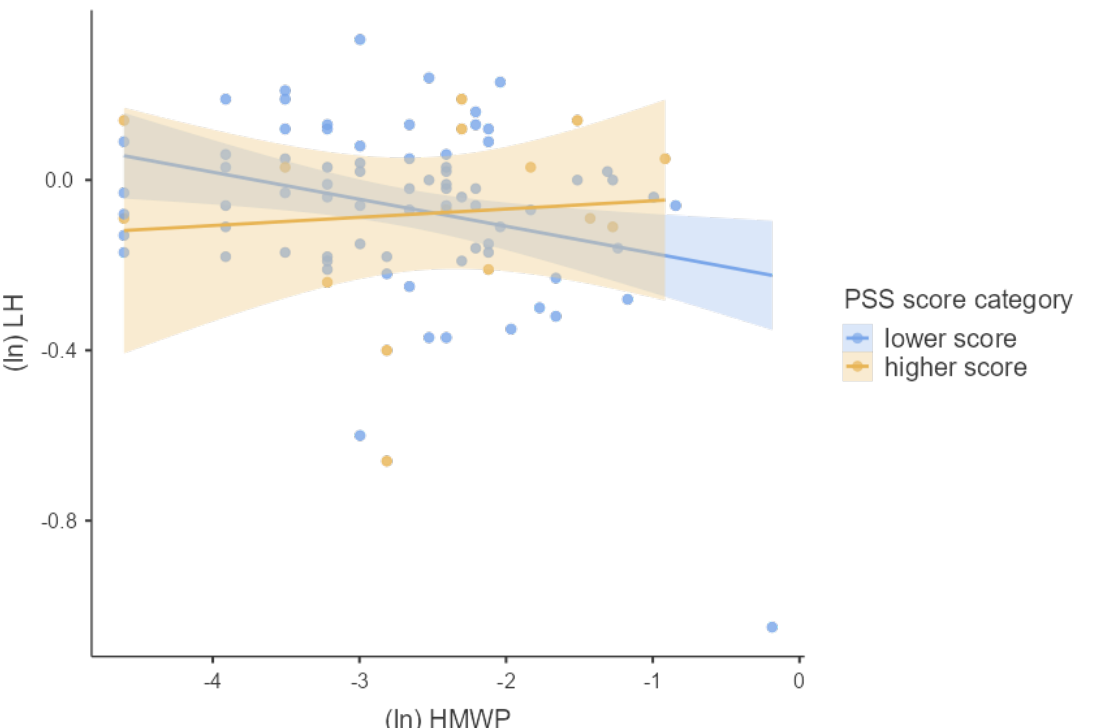
Figure 5. The associations between the concentrations of LH and DiNP based on the PSS score category stratification; Legend: DiNP — molar sum of di − iso − nonyl phthalate metabolites, ln — log transformation, LH — luteinizing hormone, PSS — perceived stress scale.